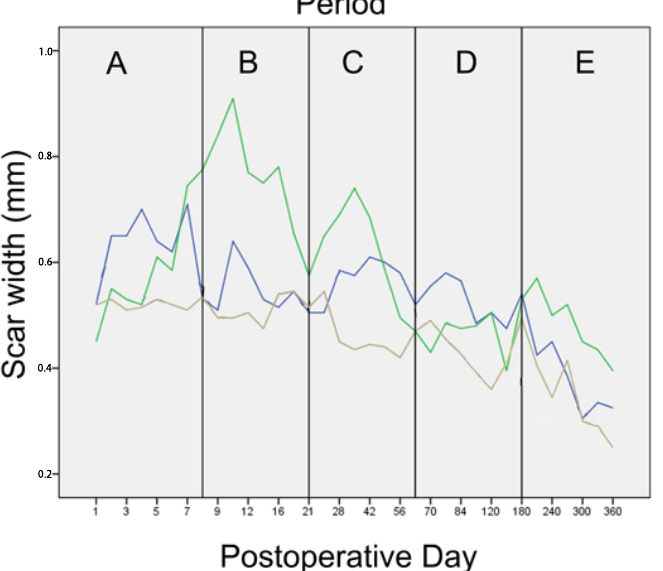
Figure 5. Median scar width (in mm) for each technique (blue: staples, green: glue, gray: intradermal)